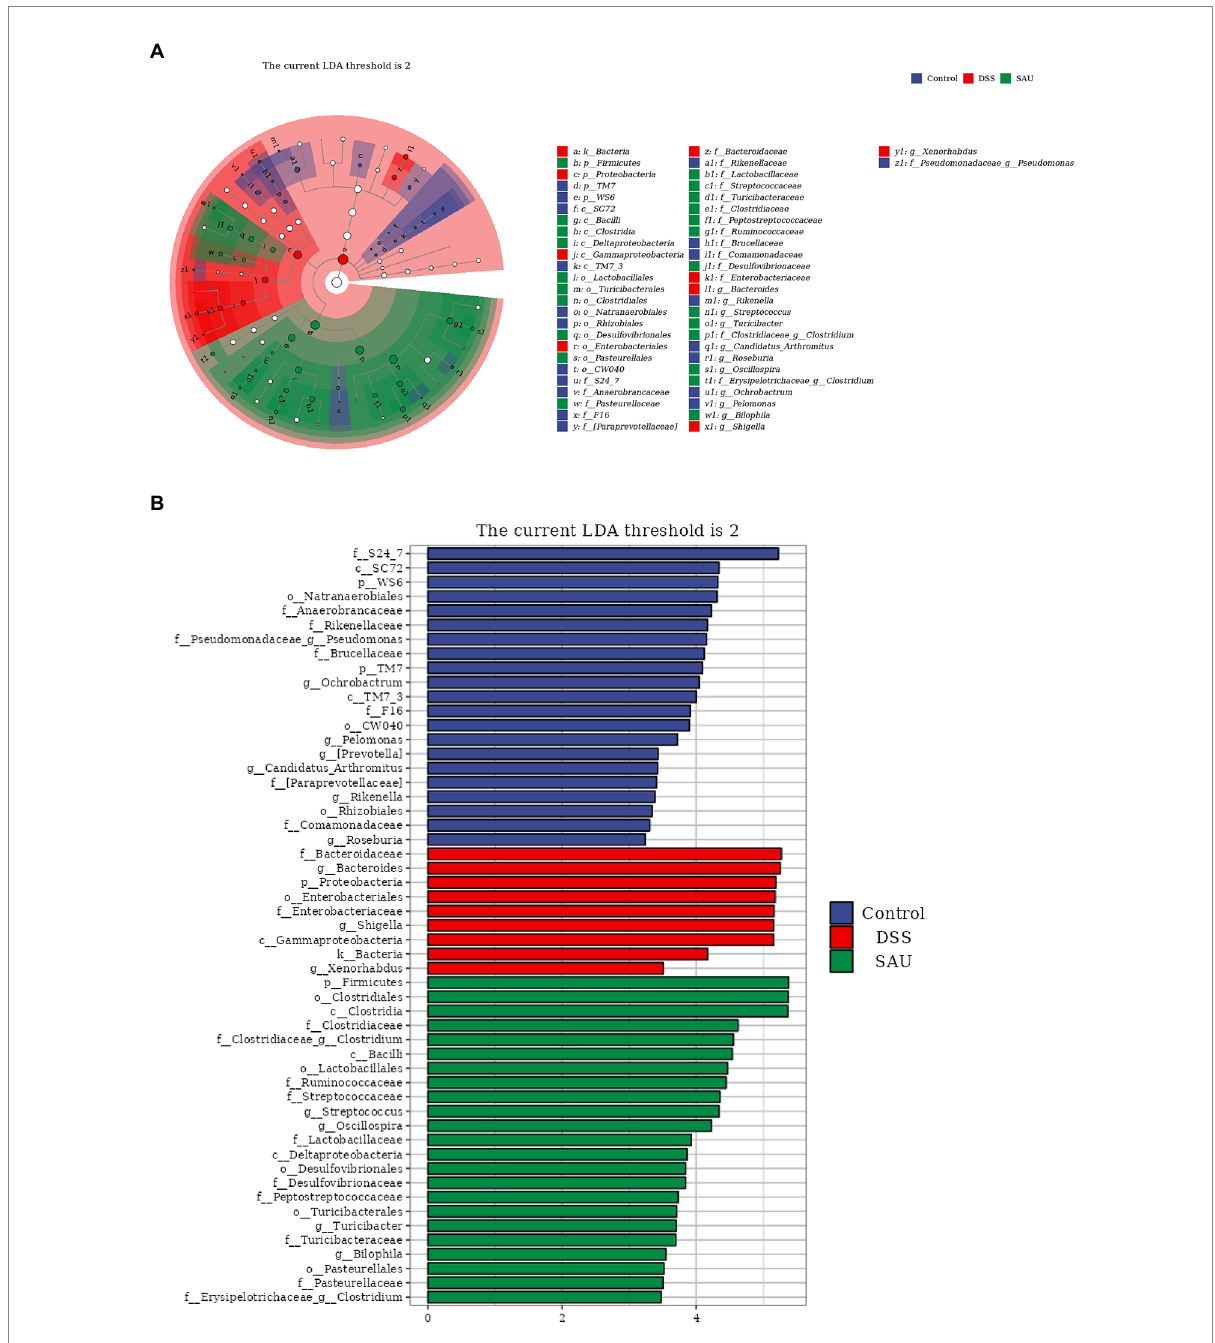
FIGURE 6 Linear discriminant analysis effect size revealed differences in taxa abundances. (A) The cladogram of detected taxa. (B) Taxa with significant differences based on linear discriminant analysis effect size with a threshold score of 2 and p <